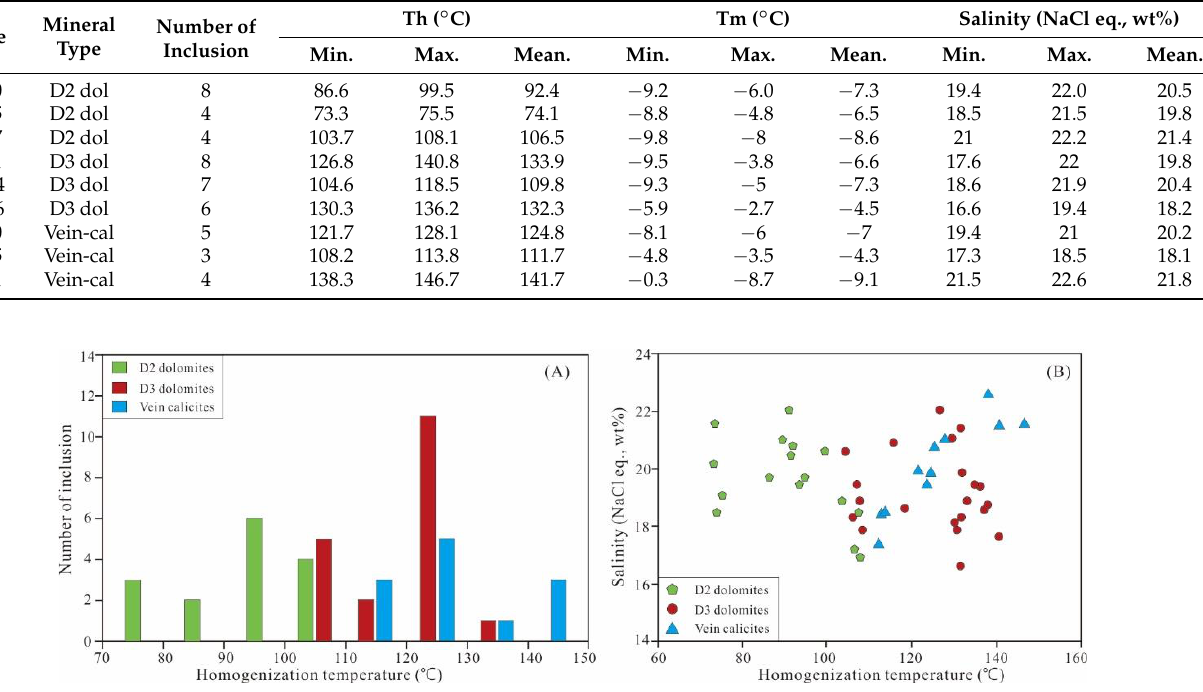
Figure 10. ( A ) T h of fluid inclusions in D2 and D3 dolomites, and vein calcite. ( B ) Cross-plot of T h versus salinity. The salinity was calculated from T m of fluid inclusions in D2 and D3 dolomites, and vein calcite.